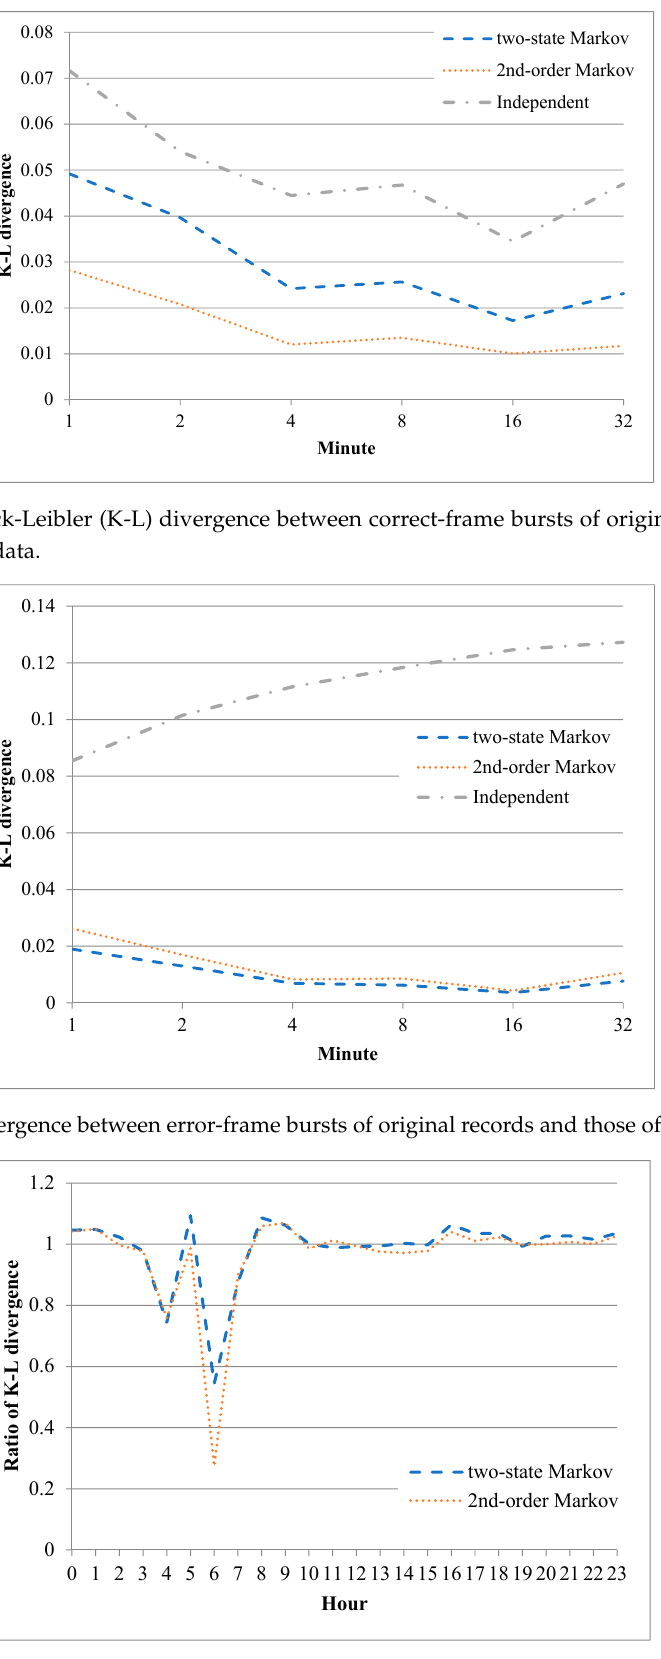
Figure 18. K-L divergence ratios of Markov error models for error-frame bursts in each hour of the experimental period (note that the K-L divergence ratio is plotted using a logarithm base 10 scale for ease of presentation). 5. Overestimation Errors of Independent Model According to the IEEE 802.15.4e standard, a data frame may be retransmitted three times at most. In other words, each data frame has a maximum of four transmission opportunities. Furthermore, after a transmitting node sends a data frame to a receiving node, the receiving node must return an ACK frame within a certain time interval. If the transmitting node receives the correct ACK frame within this interval, it deems the transmission of the data frame to have been a success. Otherwise, it performs retransmission up until the maximum number of allowable retransmissions. Assuming that the transmission quality of the wireless links can be modeled by the FDR, the transmission errors can be described by the original independent error model in OpenWSN. Let P denote the FDR from a